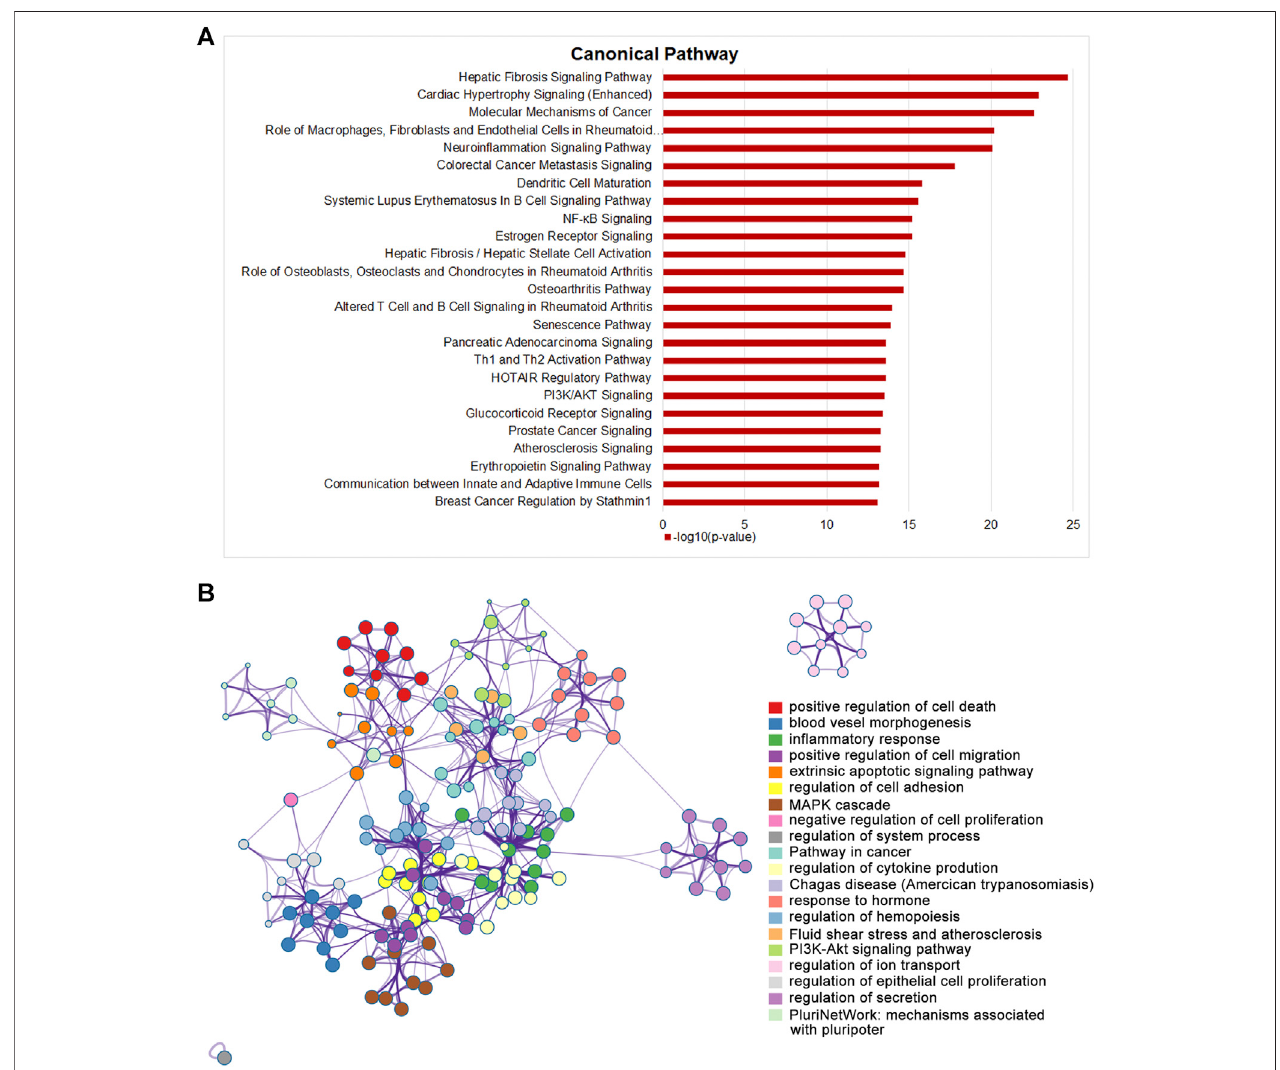
FIGURE5| STDPimproves TAC-induced CHF inmice mainly byenergy metabolism and fi broticsignaling pathway. (A) The top25classicalpathwayssigni fi cantly enriched after STDP treatment by IPA. (B) A network showing interactions among the gene clusters with signi fi cant enrichment in molecular functions and biological processes using